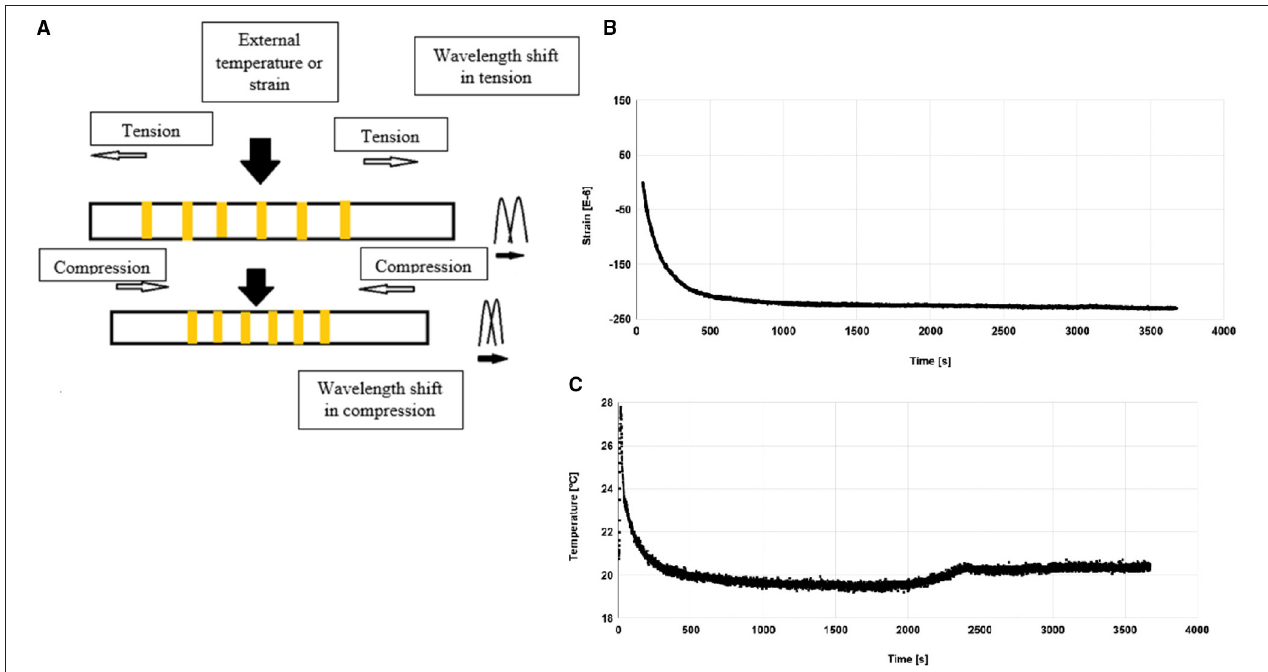
FIGURE 7 | (A) Fiber bragg grating working process during the application of pressure (27). (B) Strain evolution of bulk flow resin during polymerization (28). (C) Temperature evolution of bulk flow resin during polymerization (29).